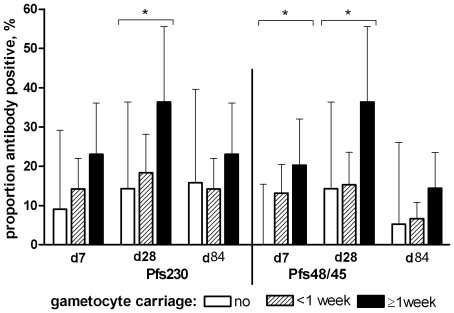
Pfs230 and Pfs48/45 antibody prevalence in relation to the duration of exposure to gametocytes during follow-up.Bars indicate total antibody prevalence in individuals who did not develop gametocytes during follow-up (clear bars), individuals who had gametocytes detected by microscopy on only one occasion (shaded bars, less than one week) and individuals who had gametocytes detected on at least two consecutive visits that were at least 7 days apart (filled bars, ≥1 week); error bars indicate the upper limit of the 95% confidence interval. On day 7 and 28 after enrolment, the number of observations from individuals without gametocyte exposure was 22, from individuals with gametocytes <1 week 69, and from individuals with gametocytes for ≥1 week 25. On day 84, these figures were 19, 69 and 25. The asterisks indicates a statistically significant positive trend between antibody responses and duration of exposure to gametocytes (p<0.05).